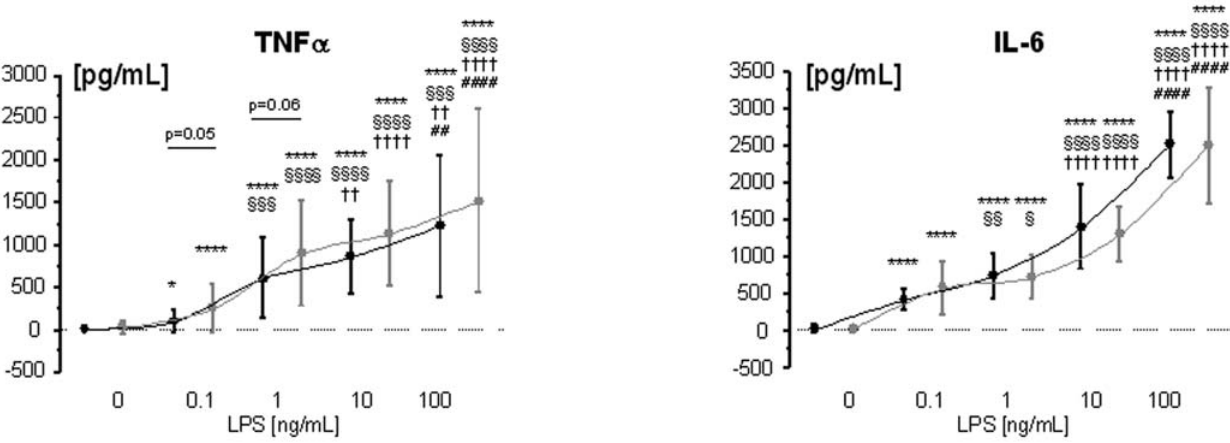
Figure 1. LPS-stimulated production of TNF a (panel A) and IL-6 from whole blood from healthy control subjects (n=11, black line) and patients with CHF (n=42, gray line). * vs. unstimulated control (0 ng/mL LPS); 1 vs. 0.1 ng/mL LPS; { vs. 1 ng/mL LPS; # vs. 10 ng/mL LPS. One symbol denotes p , 0.05, two symbols p , 0.01, three symbols p , 0.001, four symbols p , 0.0001.